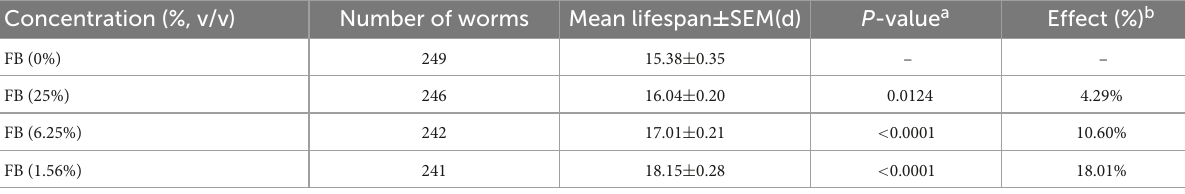
Isoberberine (FC 214.07), Dihydrokaempferol (FC 6.81)